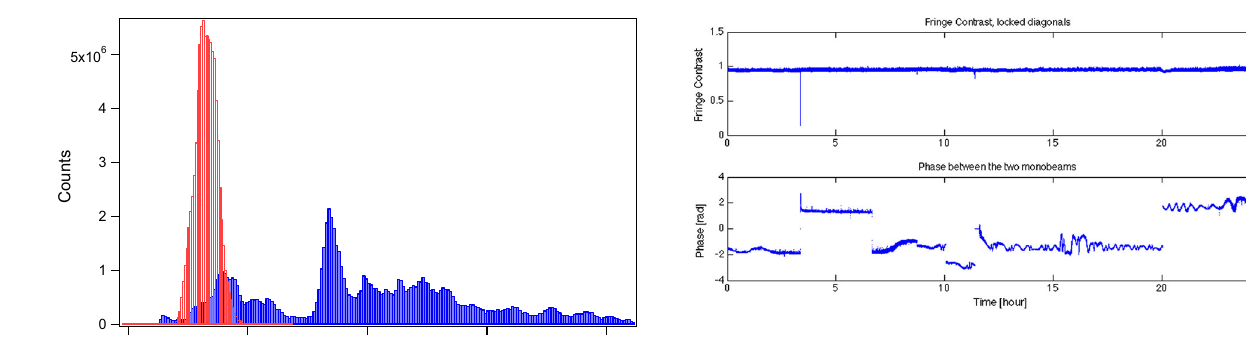
rotation rate Ω = 7 . 2922 × 10 − 5 rad/s, in agreement with the Earth rotation rate Ω ⊕ = 7 . 292115 × 10 − 5 rad/s. With